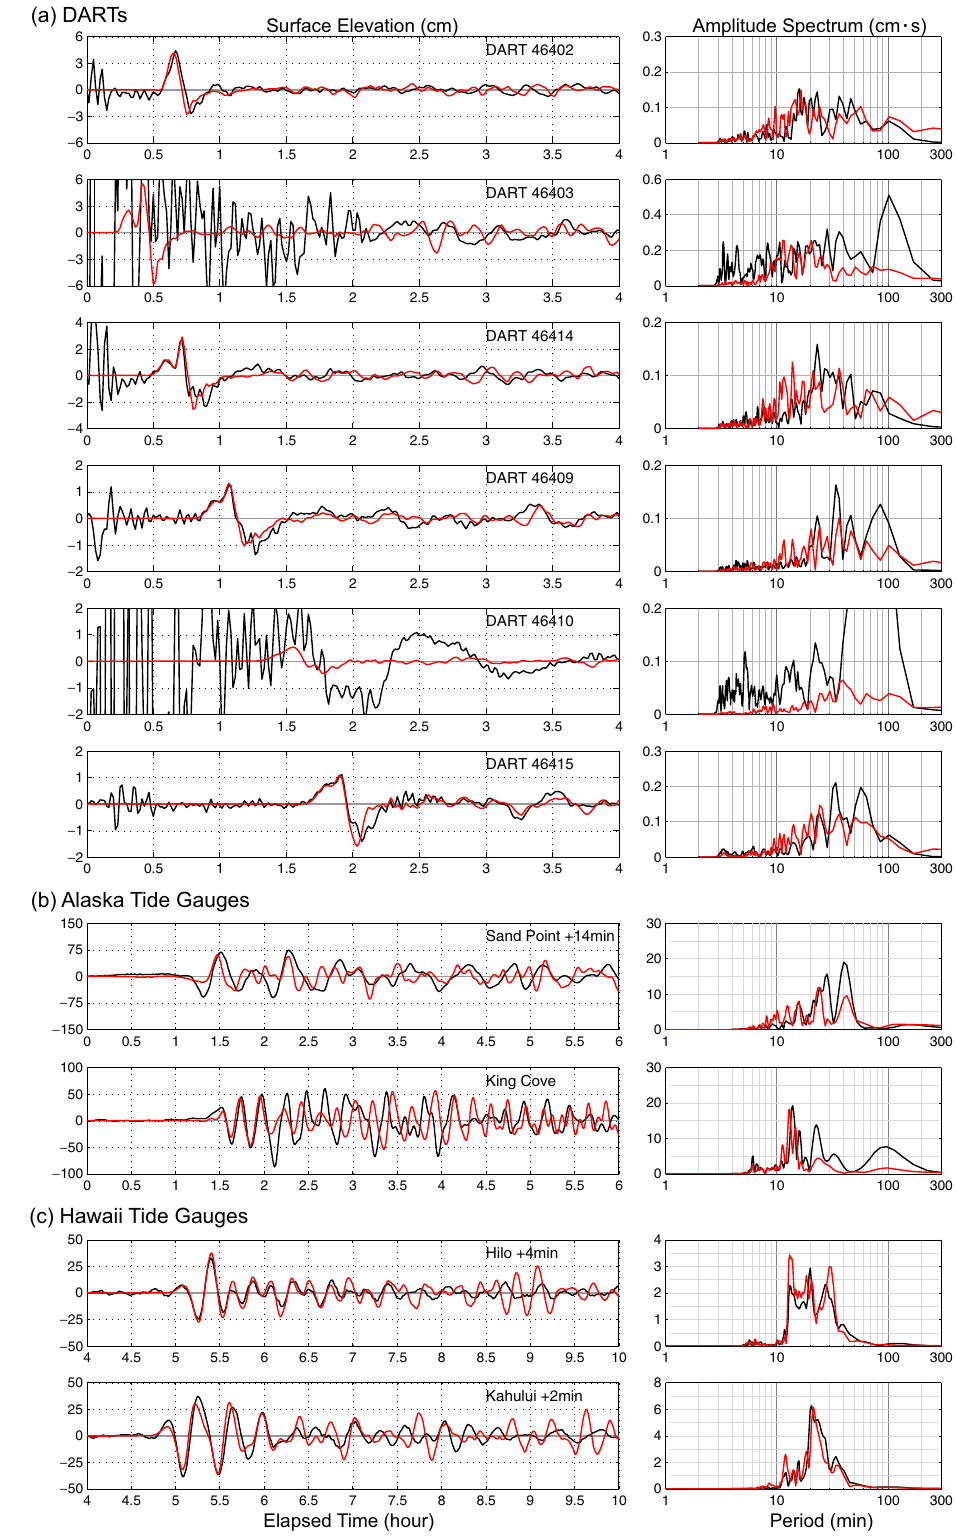
Fig.8|Tsunamiwaveformpredictionsforthethree-faultfast-slipandslow-slip model. Observed(black)andpredicted3-fault(red)tsunamisurfaceelevationtime series(leftcolumn)andspectra(rightcolumn)forDARTandtidegaugestationsfor